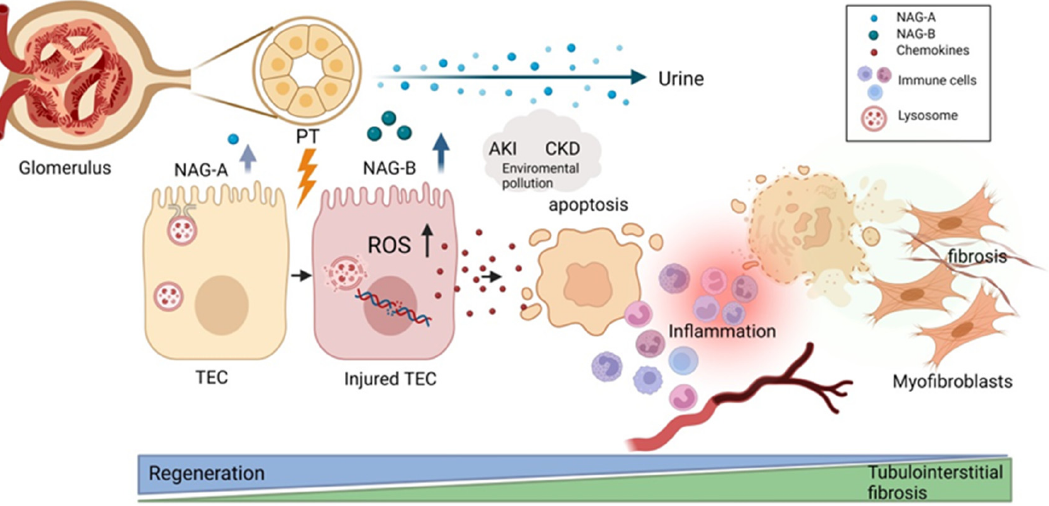
Figure 2. Schematic illustration of NAG excretion to urine upon kidney injury in relation to regenerative vs. fibrotic kidney processes. Kidney stress induces the activation of the ROS pathway, triggering the apoptosis/necrosis of proximal tubular epithelial cells (PTECs). If the sustained injury overwhelms the regenerative capacity of the tissue, the proinflammatory and profibrotic cascade can take over. The released chemokines then support the infiltration of immune cells, resulting in acute kidney injury, which can over time progress to chronic kidney disease. NAG-B isoform is readily excreted to urine after kidney injury as a result of lysosomal damage in comparison to NAG- A, which is normally found in small amounts in healthy urine samples. PTEC—proximal tubular epithelial cell; NAG—N-acetyl-beta-D-glucosaminidase; PT—proximal tubule; AKI—acute kidney injury; CKD—chronic kidney disease; ROS—reactive oxygen species. Image created with Bioren- der.com.